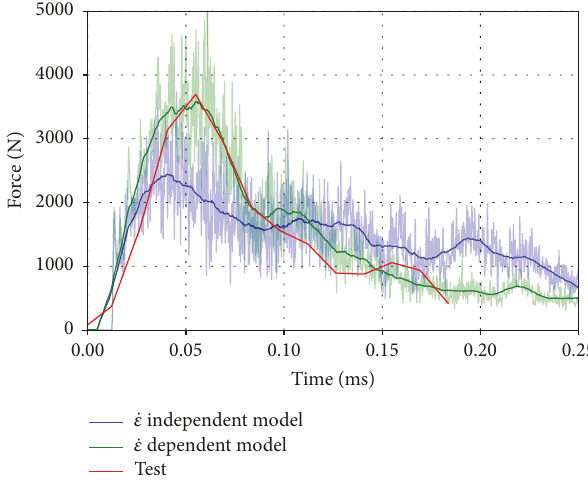
Figure 16: Hollow sphere impacting a rigid surface at 70 m ⋅ s −1 . Comparison of the force of impact as a function of time for the experimental and numerical results. Raw and smooth (by moving average) numerical results are presented.